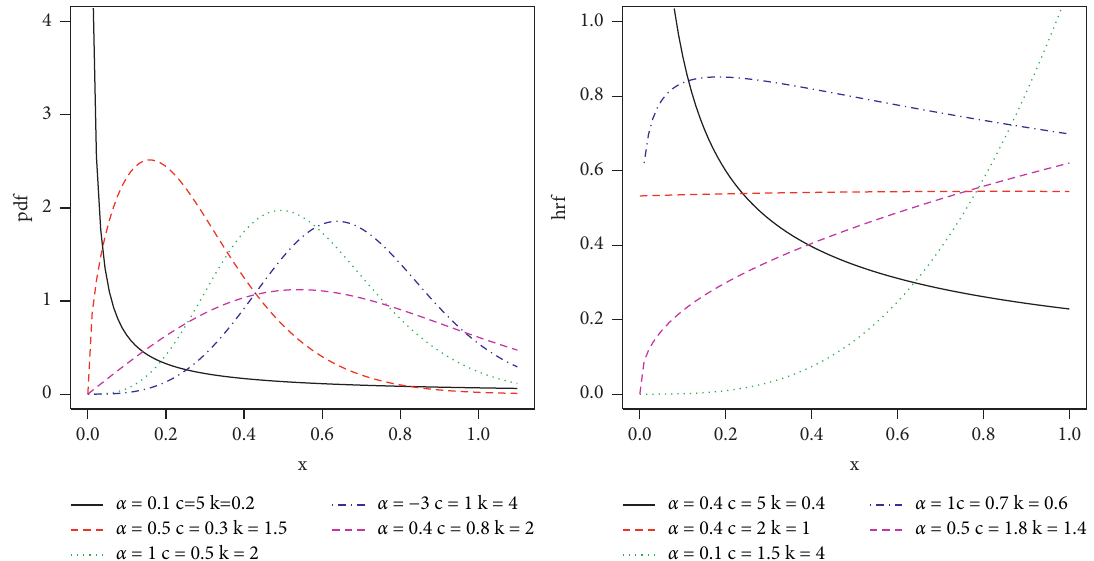
Figure 1: Plots showing different shapes of the pdf (a) and hrf (b) of the NTMW